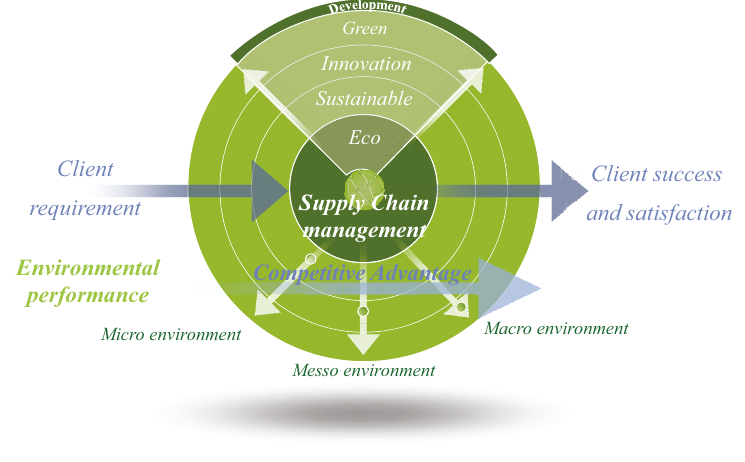
Fig. 1. Green supply chain management